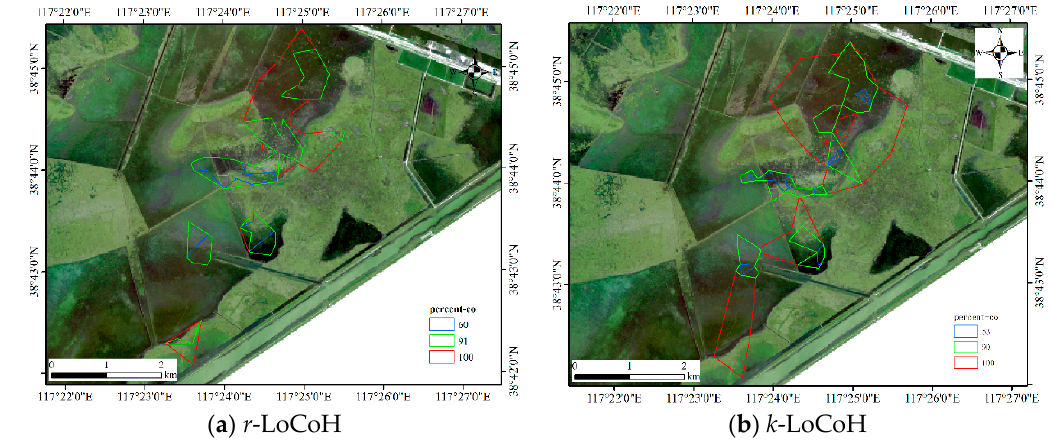
Figure 14. HRs estimated by the LoCoH methods for Dataset 1.